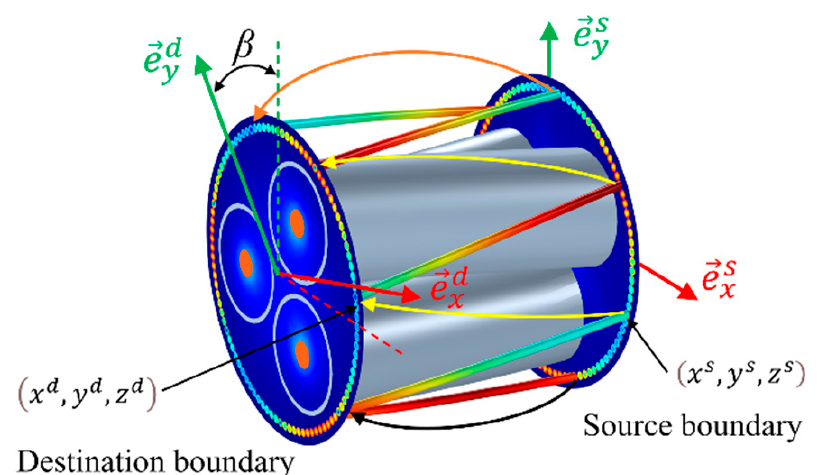
Figure 4. Rotated boundary conditions in a TCAC for a model length of CP /7.